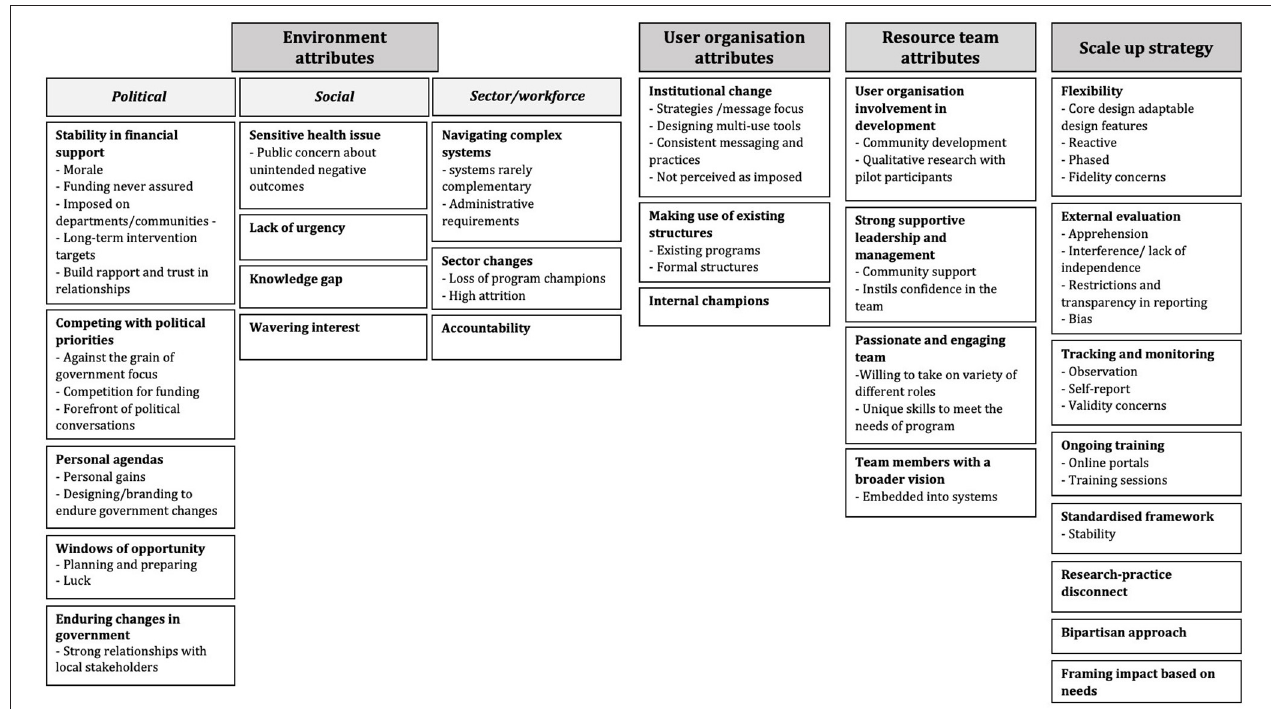
FIGURE 2 | Major themes and subthemes from interviews with individuals involved in scale up. Themes grouped by core areas (dark gray boxes) of the WHO ExpandNet framework for scaling up (13). Bold text indicates a main theme; subthemes listed underneath where applicable.